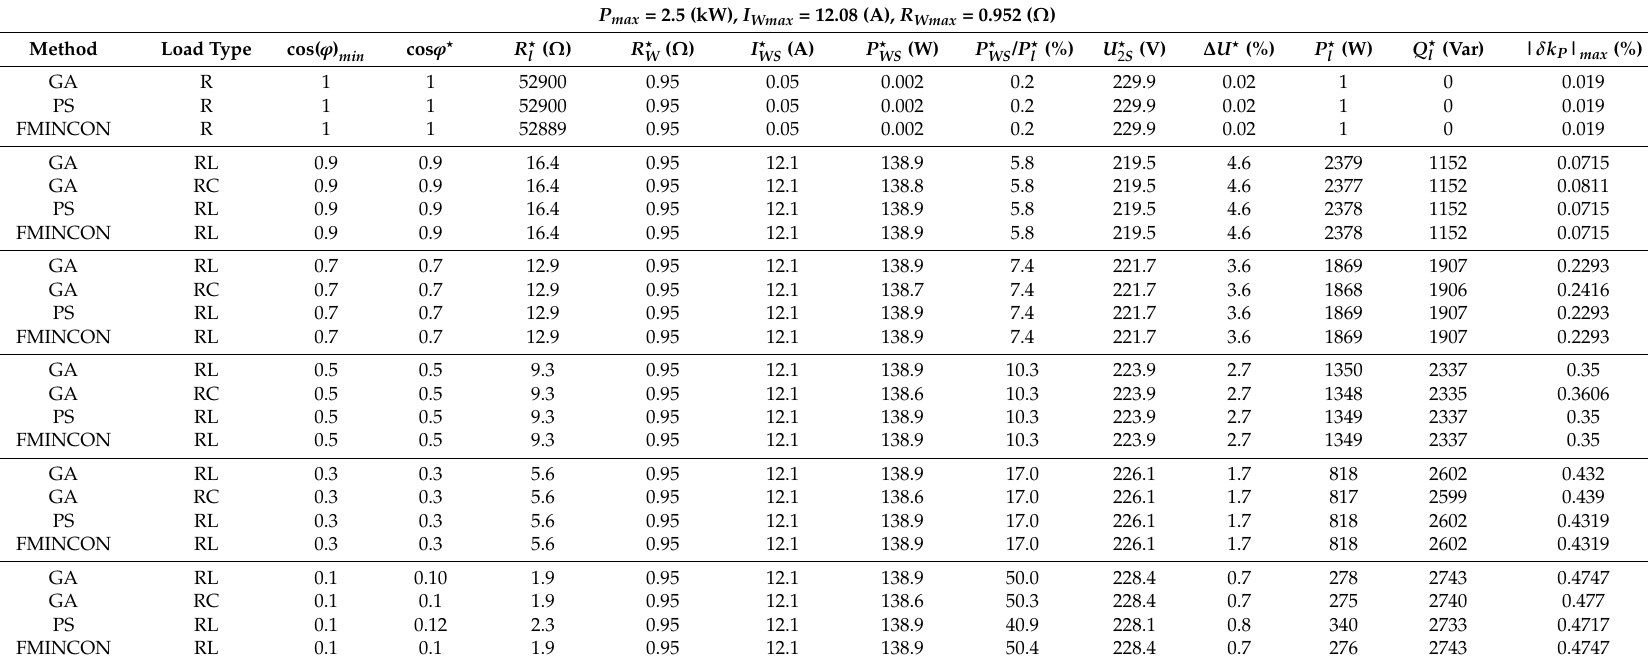
Table 1. Results obtained by GA and PS methods for R , RL , RC type